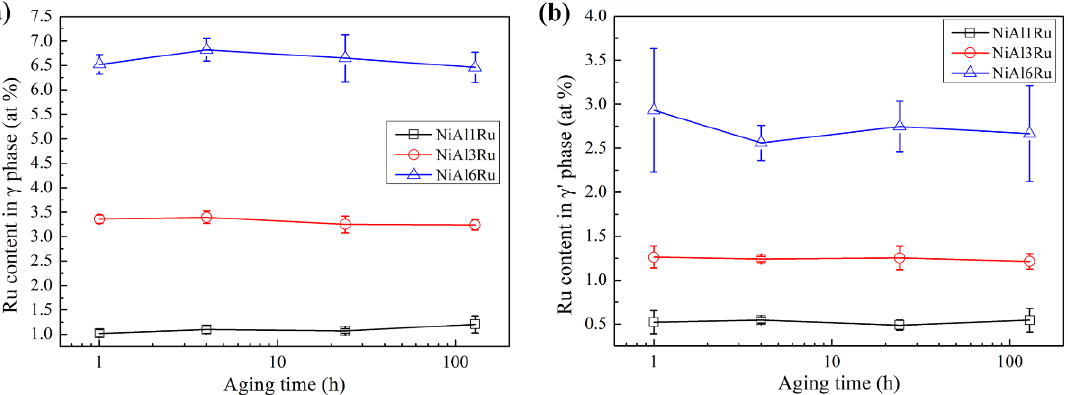
Figure 4. The content of Ru in γ phase ( a ) and γ′ phase ( b ) of the alloys after heat treatment. The horizontal x-axis is converted to logarithmic coordinates for clarity.